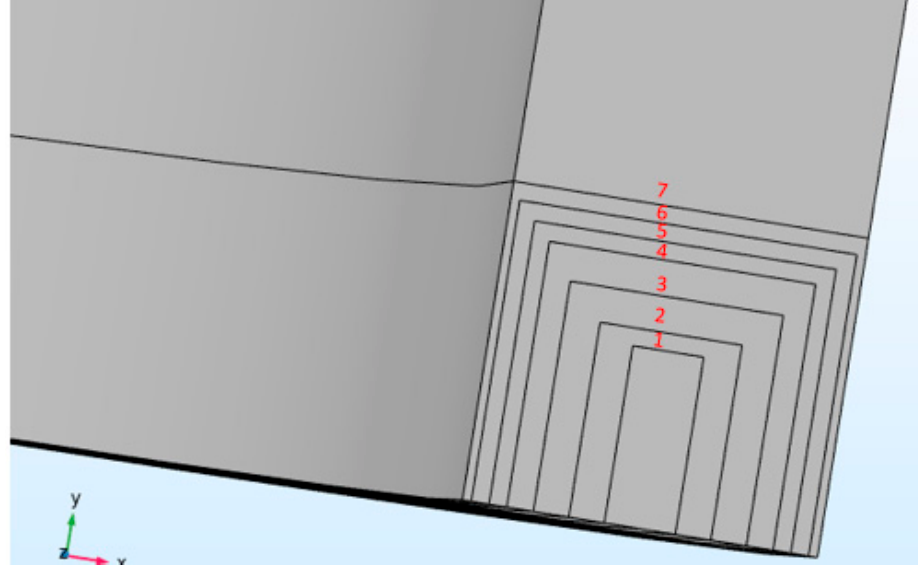
Figure 5. Line and surface integration paths for J-integral independence study .